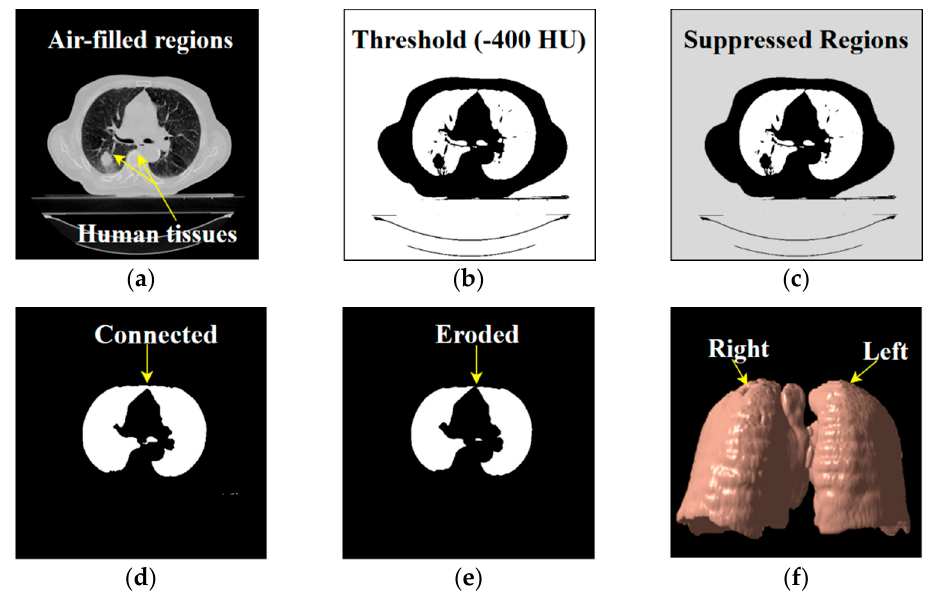
Figure 4. Segmentation of the lung regions: ( a ) input 2D computed tomography (CT) slice, ( b ) segments of air-filled regions, ( c ) suppressed air-filled regions outside of the body, ( d ) connection between the two lungs, ( e ) separation of the left and right lungs using morphological erosion, ( f ) isotropic structure of the segmented lung regions.